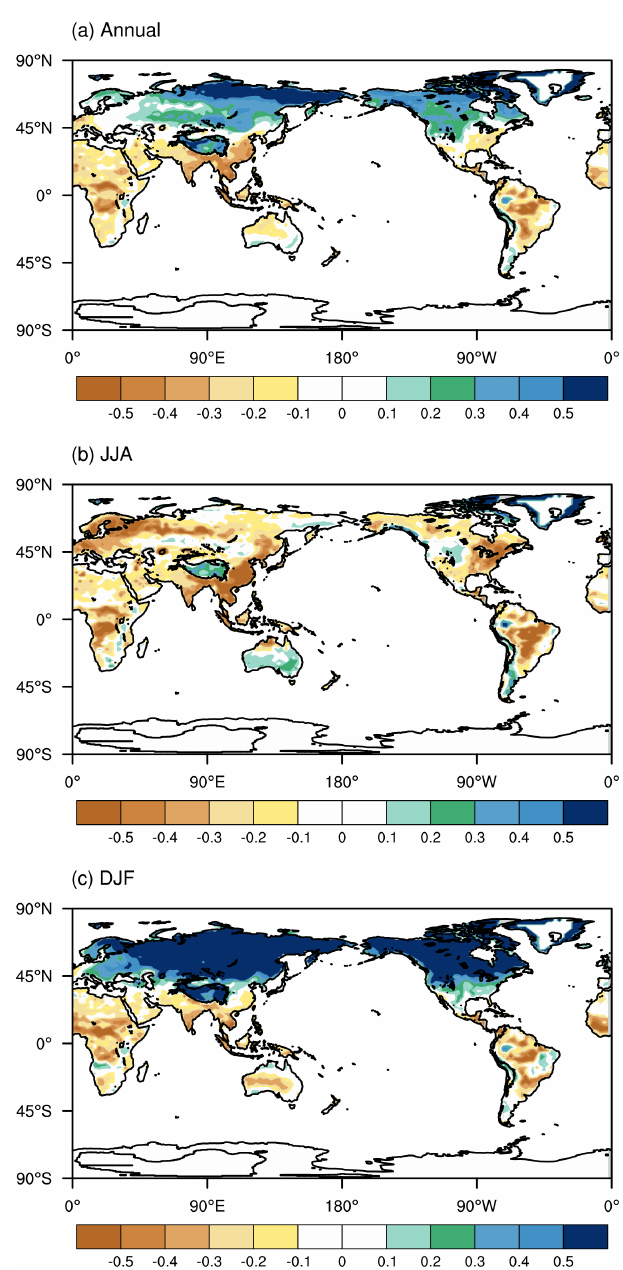
Figure 2. Spatial distribution of (a) annual, (b) JJA (June–July– August) and (c) DJF (December–January–February) mean correla- tion coefficients r between the subgrid surface sensible and latent heat fluxes in the EXP_COR